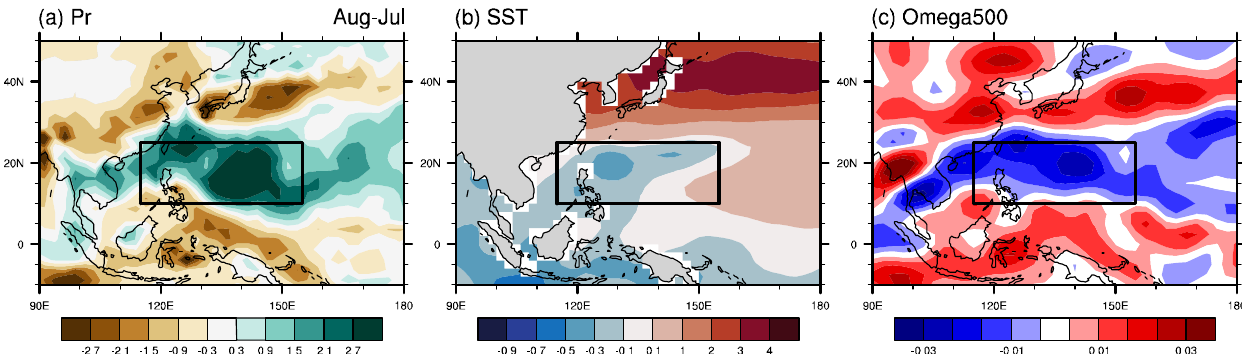
Figure 1. Climatological ( a ) precipitation change (units: mm/d), ( b ) sea surface temperature (SST) change (units: °C) and ( c ) vertical velocity at 500-hPa change (Units: Pa/s) from July to August in the western North Pacific region. The change means the difference between August and July. The black box denotes the region mainly focused in this study (10–25° N, 115–155° E).